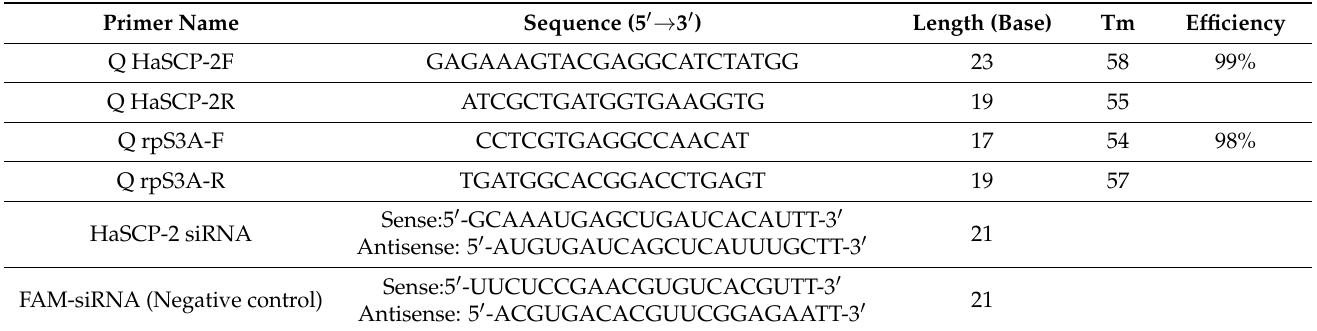
Table 1. Primers for quantitative real-time PCR and